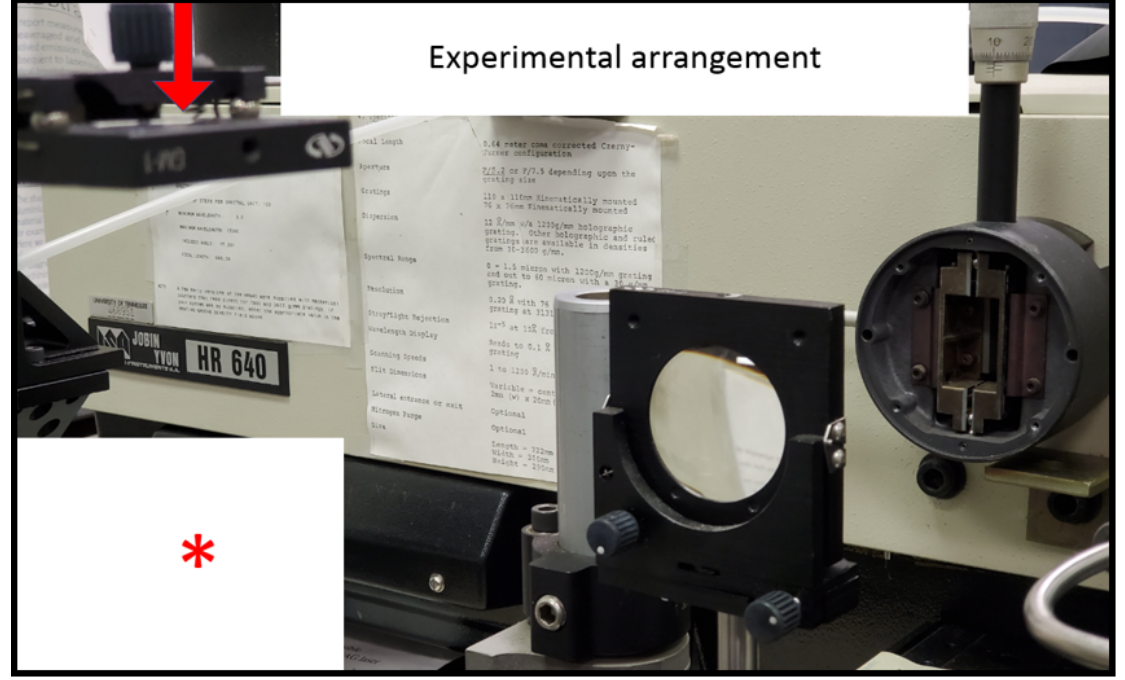
Figure 4. Experimental arrangement for time-resolved spectroscopy. The laser beam (red arrow) is focused to generate optical breakdown, indicated by the asterisk in the lower left of the photograph. The plasma is 1:1 images onto the slit of the spectrometer. Time-resolved data are recorded with an intensified charge-coupled device (not shown) positioned at the exit plane of the spectrometer.